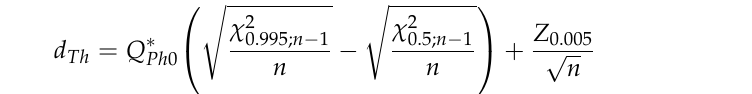
be the length of the bottom of